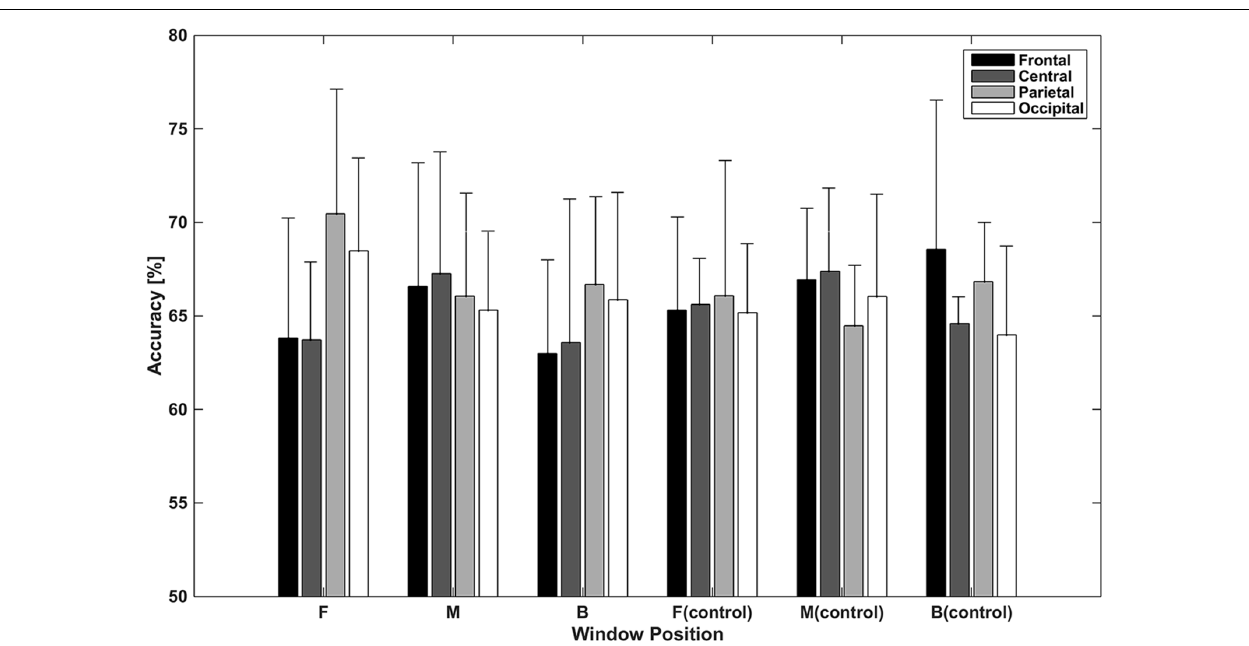
FIGURE 5 | Classification accuracies using independent components categorized by spatial pattern. Values depicted are means of the highest accuracies obtained in left vs. right and top vs. bottom classifications averaged across subjects.